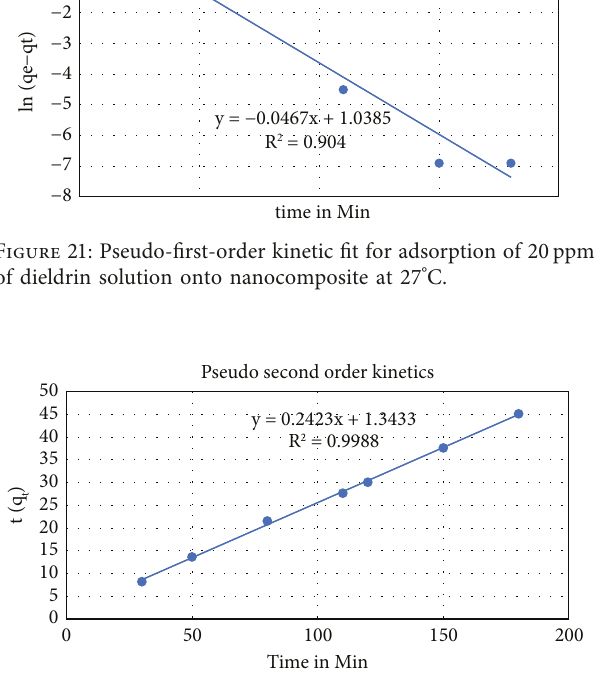
Figure 22: Pseudo-second-order kinetic fit for adsorption of 20ppm of dieldrin solution onto nanocomposite at 27 ° C.